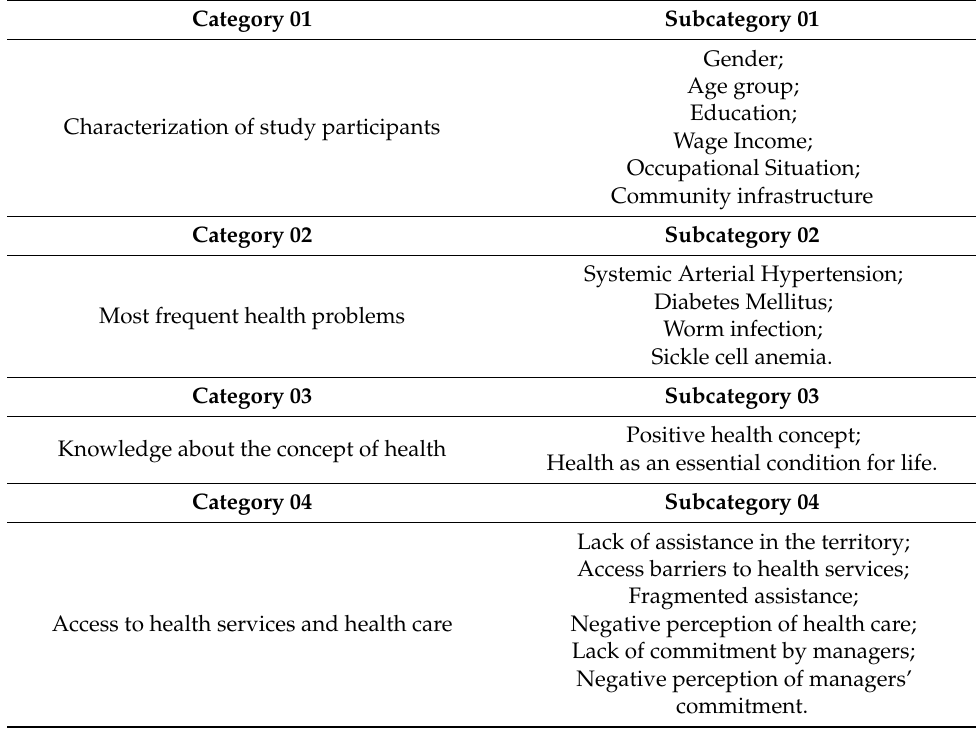
Table 2. Categories and subcategories elaborated from the speeches of the participants. Northern Tocantins Region /Brazil, October 2017 to July